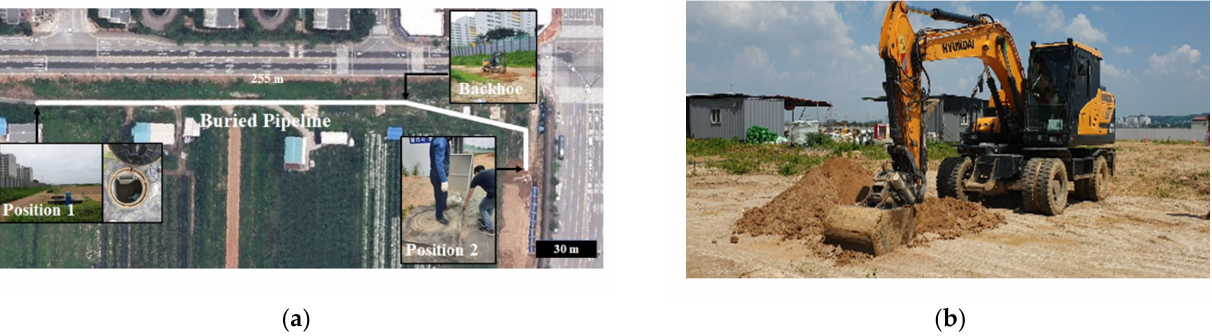
Figure 12. Schematics for the experiments: ( a ) pipeline layout on map and ( b ) backhoe excava- tion.